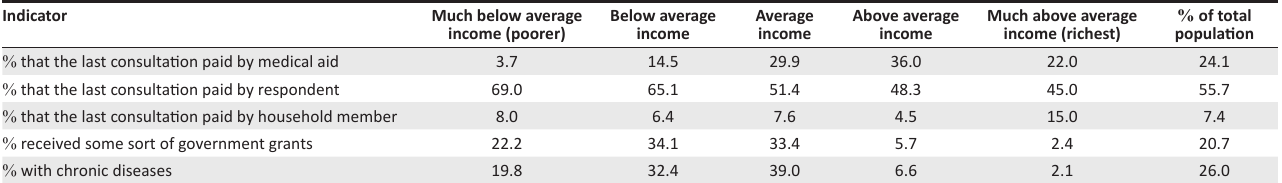
TABLE 1: Key indicators by income classification of households (individual level – adult).